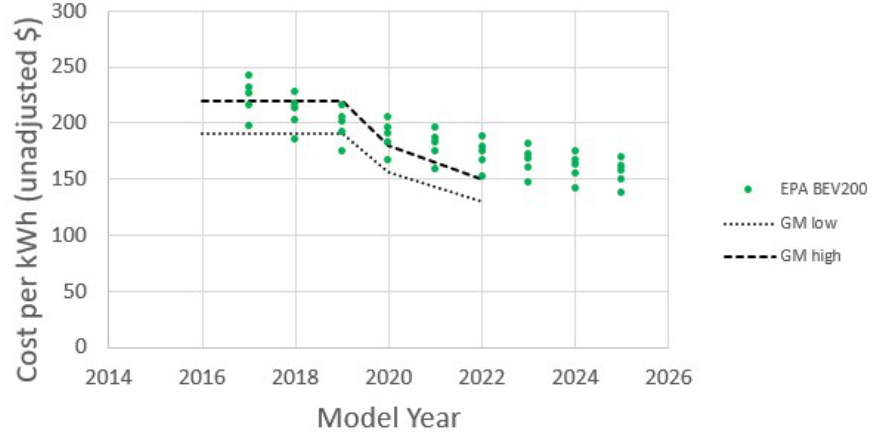
Figure 5. Comparison of Estimated Pack-Converted Chevy Bolt Costs to Post-Processed BEV200 estimates.